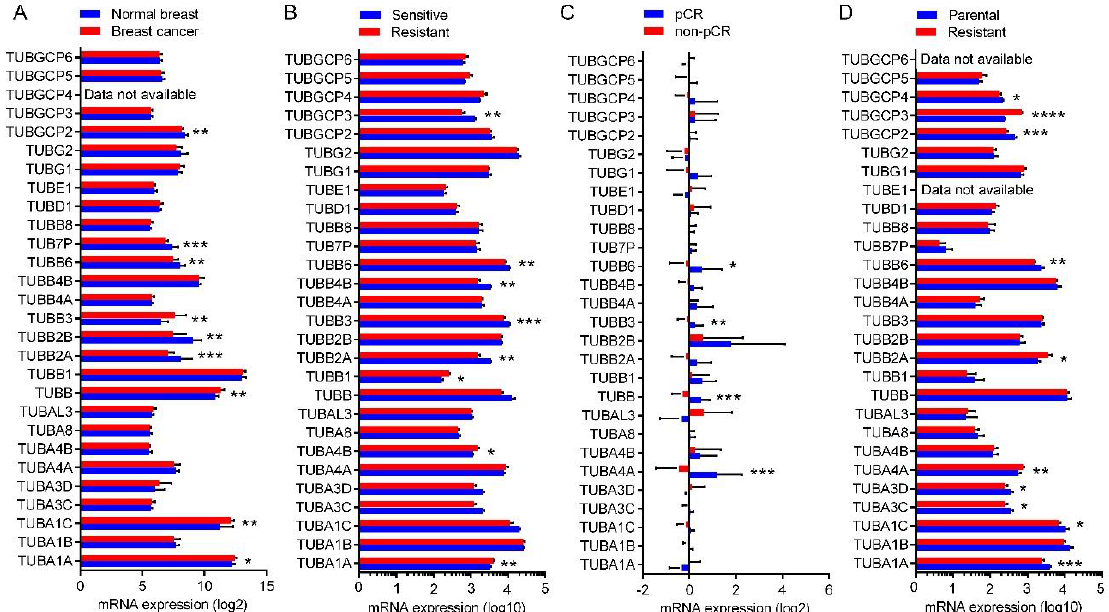
Figure 6. mRNA expression levels of the tubulin genes in normal breast and BC tumor tissues, taxane-sensitive and resistant BC tumor samples. ( A ) Log2 mRNA expression levels of tubulin genes in normal breast biopsies (eight samples) and BC tumors (16 samples) obtained from GEO database ID GSE22796 [68]. ( B ) Log10 mRNA expression levels of the tubulin genes in taxane-sensitive and resistant BC tumors. Data obtained from GEO dataset ID GSE99225. ( C ) Log2 mRNA expression values of the tubulin genes in the tumor biopsies from patients that achieved a pathologic complete response (pCR) (4 samples) and those with residual disease (non-pCR) (13 samples). Data obtained from GEO database ID GSE22513 [69,70]. ( D ) Log10 mRNA expression levels of the tubulin genes in the parental and paclitaxel-resistant MDA-MB-231 cells. Data obtained from GEO database ID